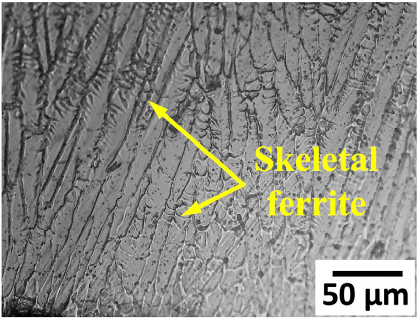
Figure 6. Skeletal ferrite microstructure in the FZ at higher magnification.